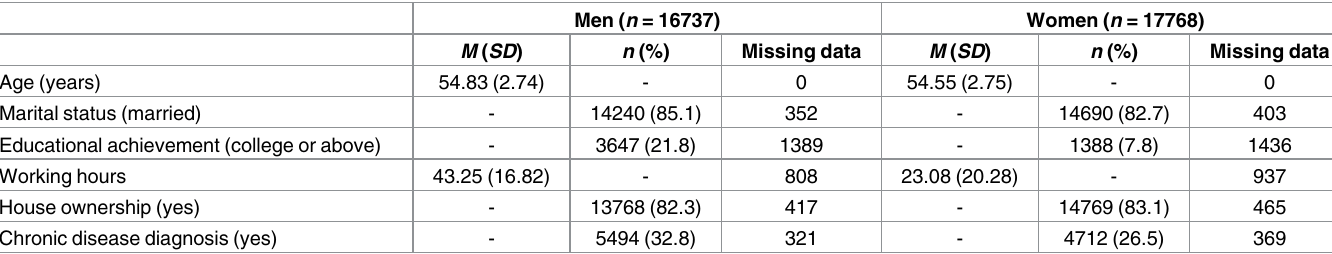
Table 1. Descriptivestatistics on demographic status, socioeconomic status, and the diagnosis of chronic disease by